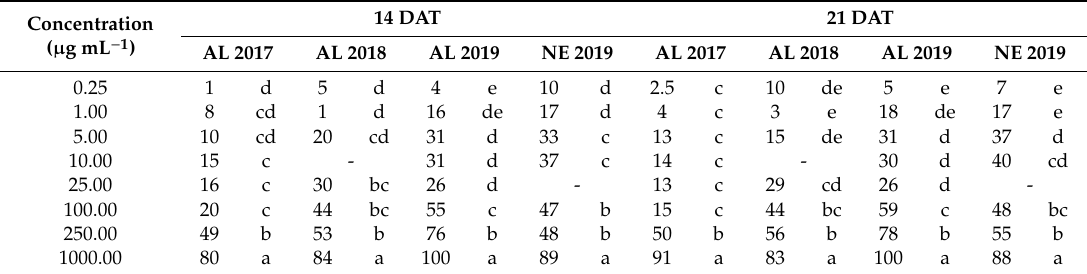
Table 6. Soybean visual injury to various concentrations of dicamba under field conditions 14 and 21 DAT A,B,C,D,E